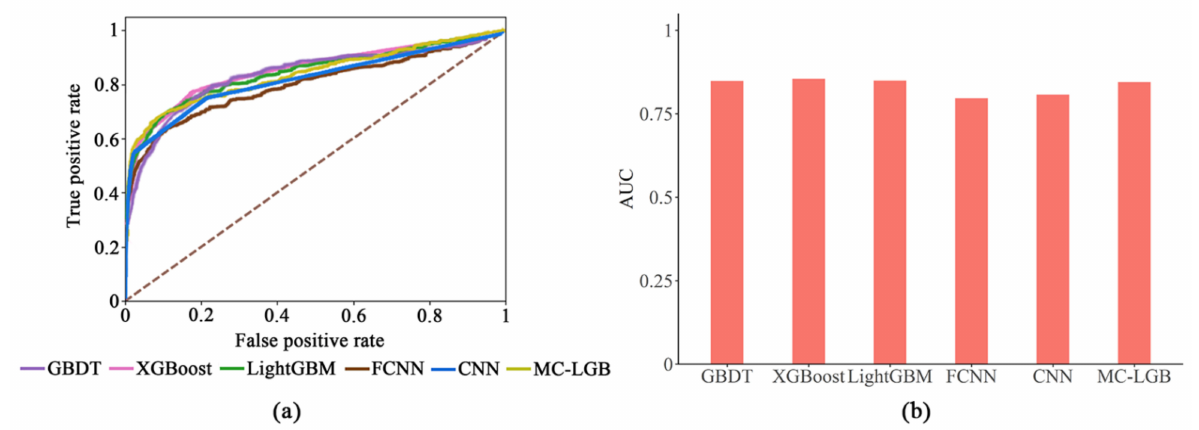
Figure 3. ( a ) ROC curves of classifiers on the KPG dataset and ( b ) AUC of classifiers on the KPG dataset.